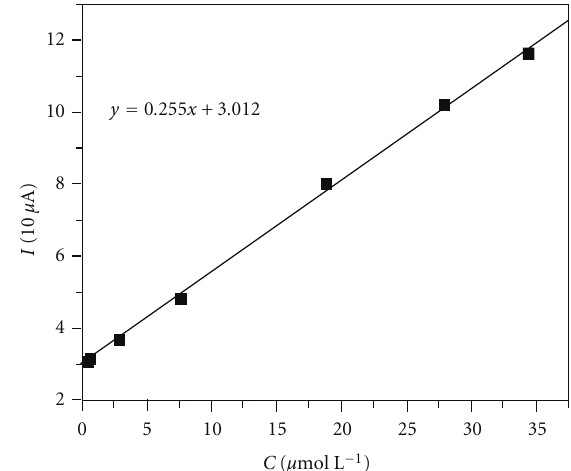
Figure 8: Calibration curve for the determination of parathion at the poly(safranine) film electrode ( n =